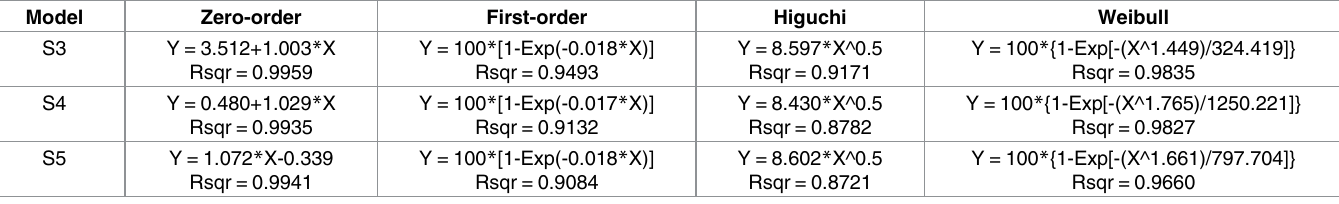
Table 9. In vitro releasekinetics models of geniposide from the optimized formulations.